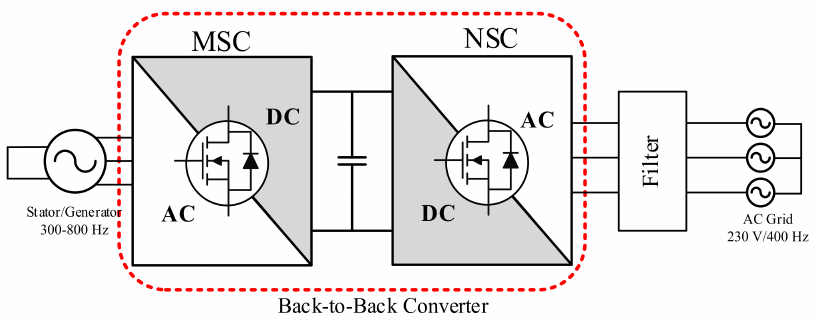
Figure 1. System diagram of the electric starter/generator in more electric aircraft. (MSC: machine-side converter; NSC: network-side converter).